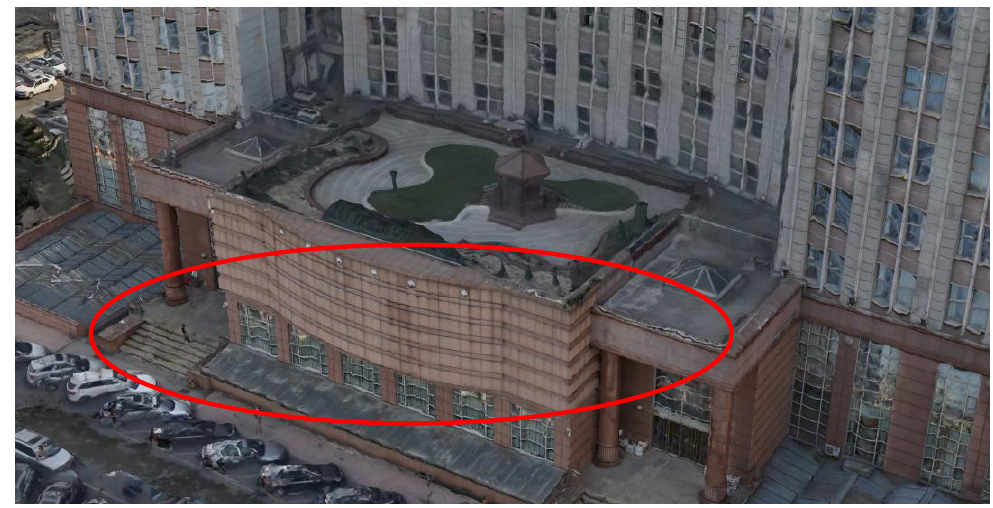
Figure 13 The air view of one big building model produced by OP and close range